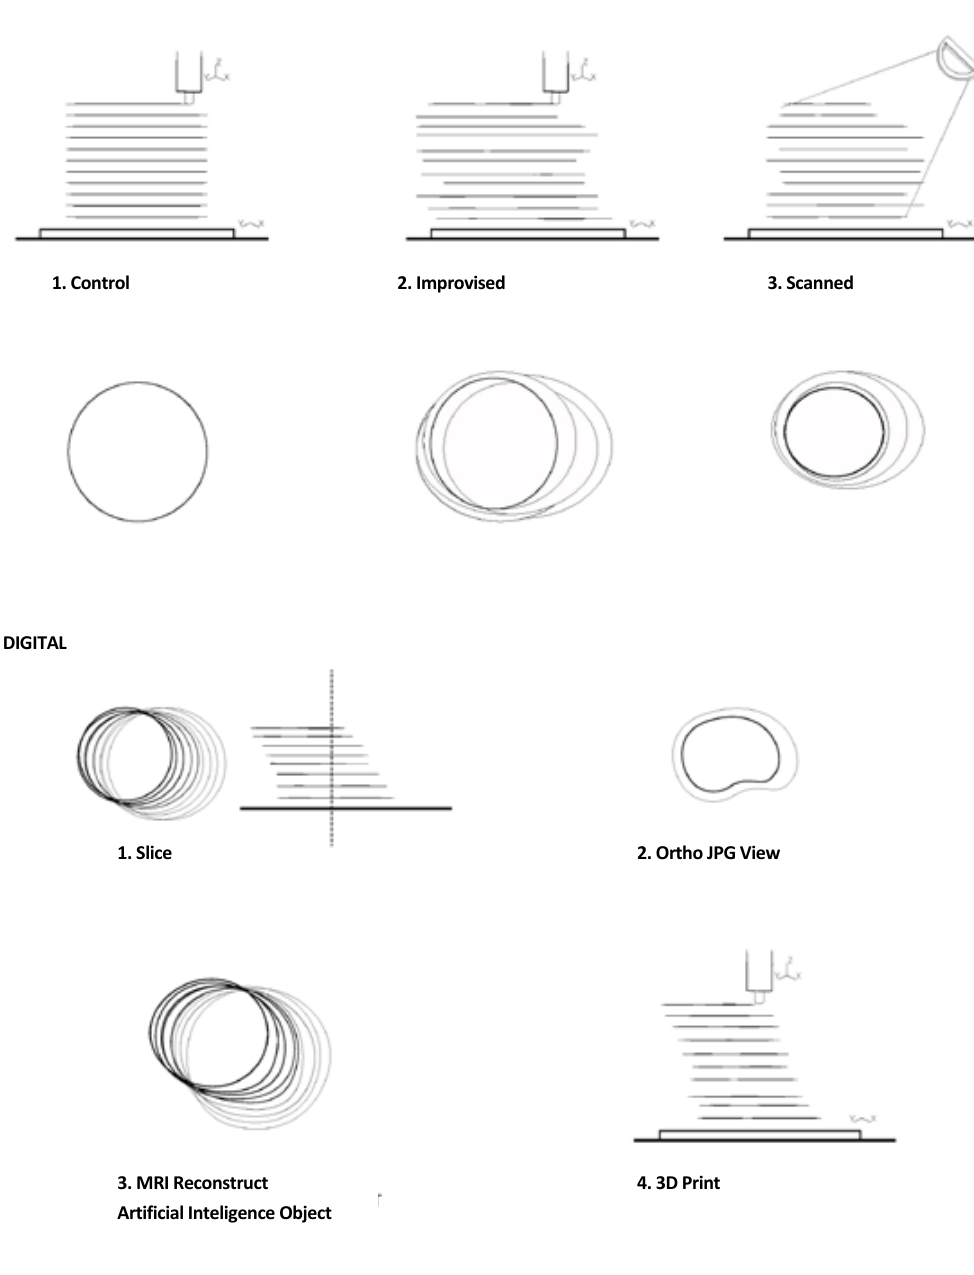
Figure 5 (page 162–163): 3D Scan in progress of improvised artefact. The pixelated image was captured during the scanning process. Though not in high visual resolution, the scan image includes the topological information vital to digitising a one of a kind, hybrid artefact. Source: author.